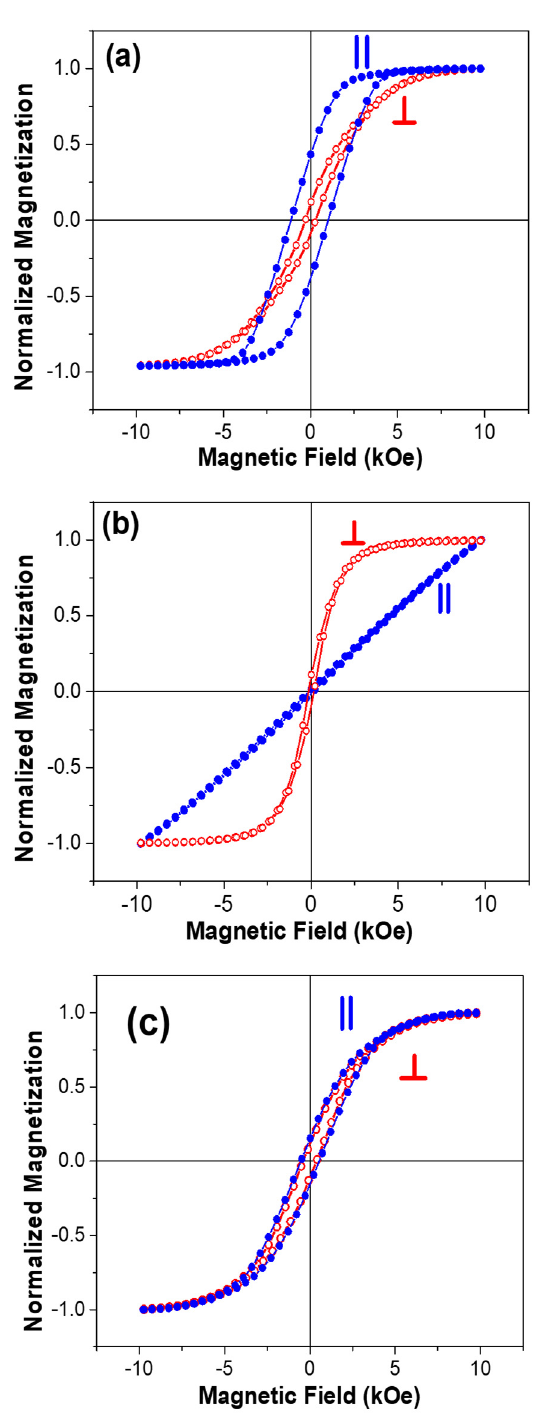
Figure 4. Room temperature normalized magnetization (M/Ms) dependence upon magnetic field with spacing-to-diameter ratio ( a ) 0.74, ( b ) 0.53 and ( c ) 0.37.